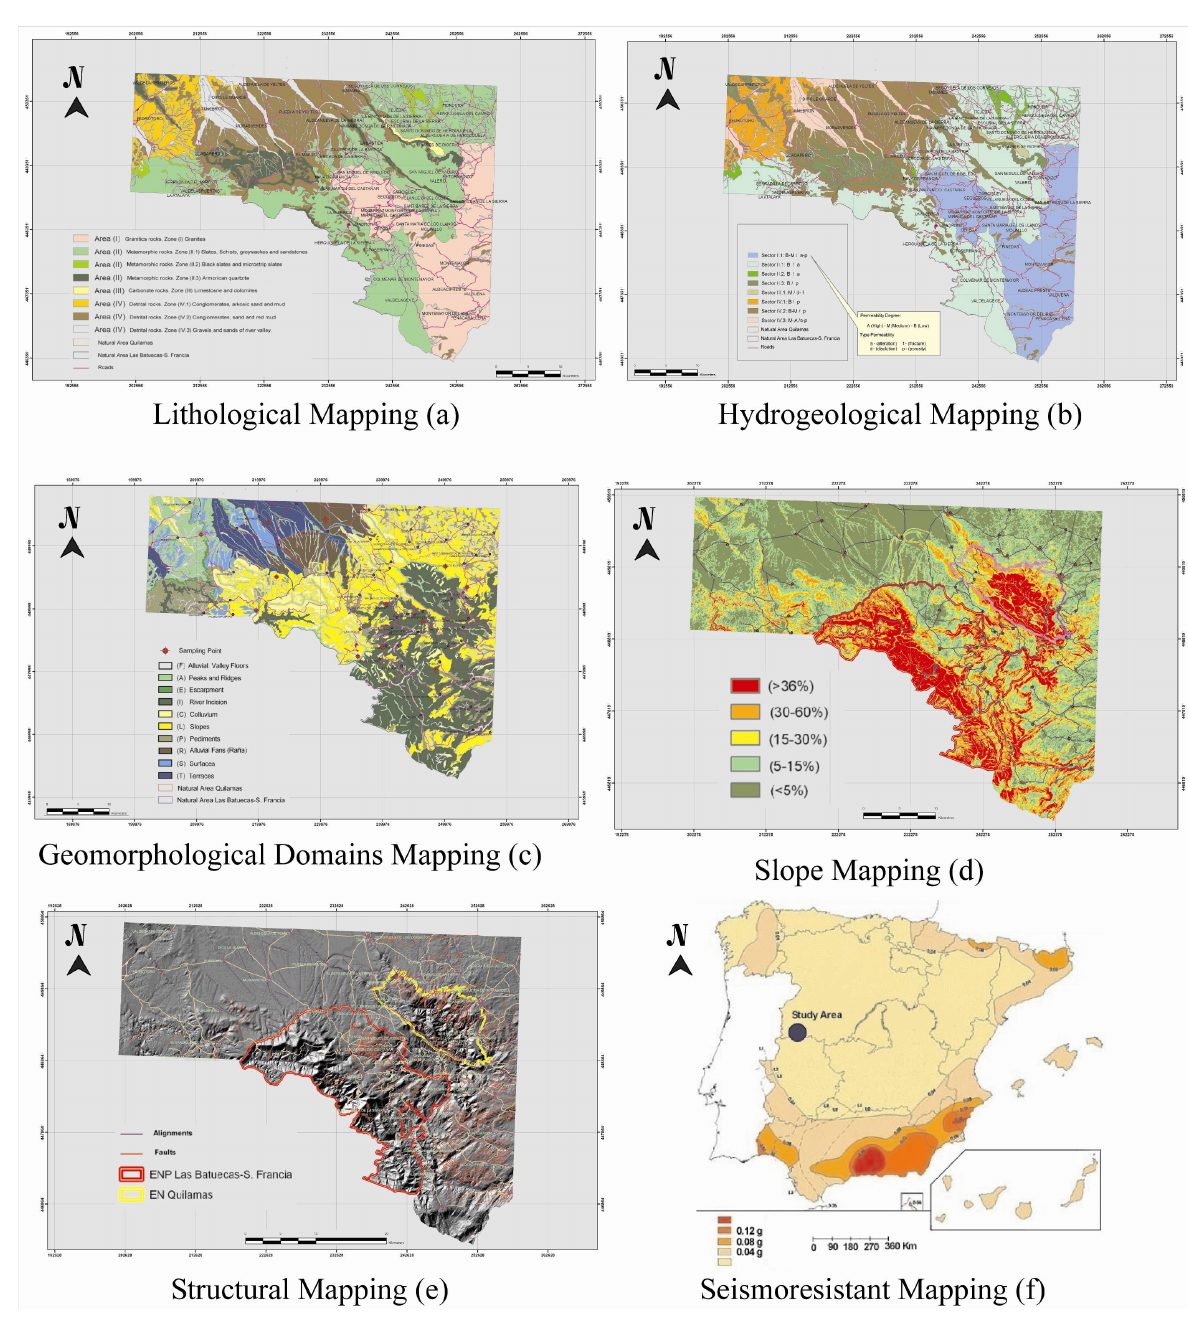
Figure 3. Parametric cartography for the sector of study: ( a ) Lithological mapping; ( b ) hydrogeological mapping; ( c ) geomorphological domains mapping; ( d ) slope mapping; ( e ) structural mapping and ( f ) seismoresistant